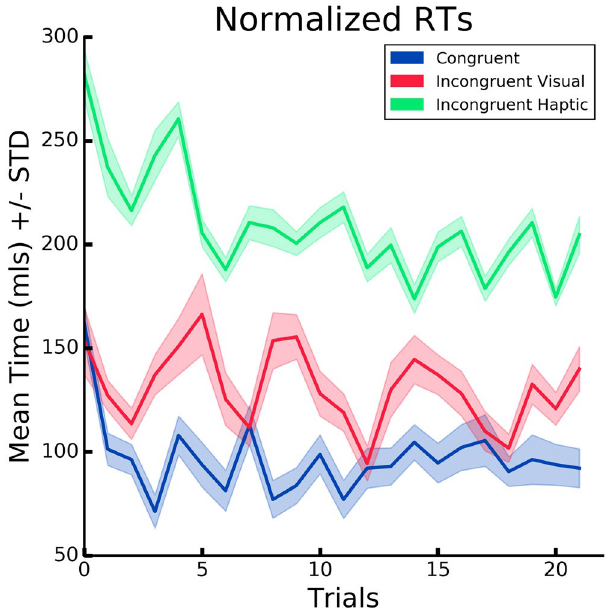
Figure 6. Response Times. Normalized mean of the response times for all the participants, defined as the intervals between the start of the stroking and subjects’ response, over time, per condition.